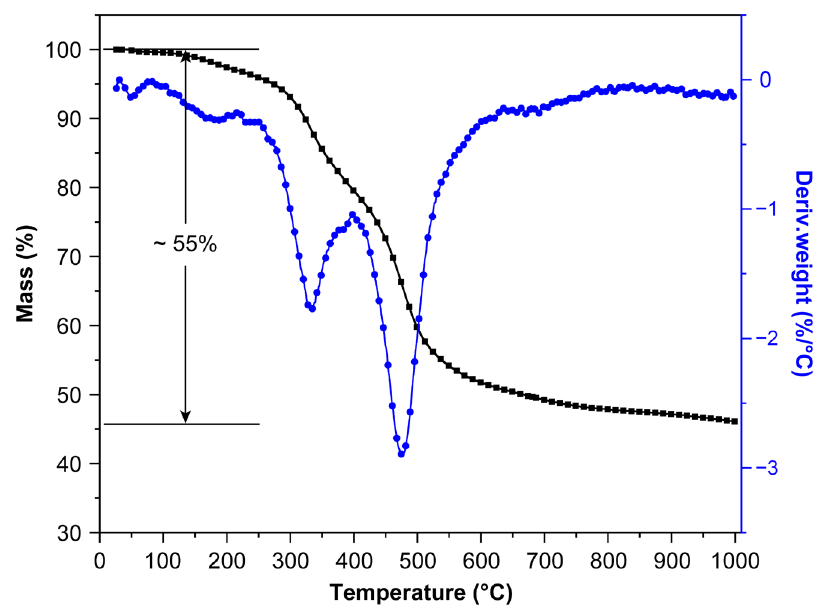
Figure 5. Thermogravimetric (TG)–differential thermogravimetric (DTG) analysis of polymer-derived aerogel (PSZ-BSAG) under nitrogen flow up to 1000 °C.